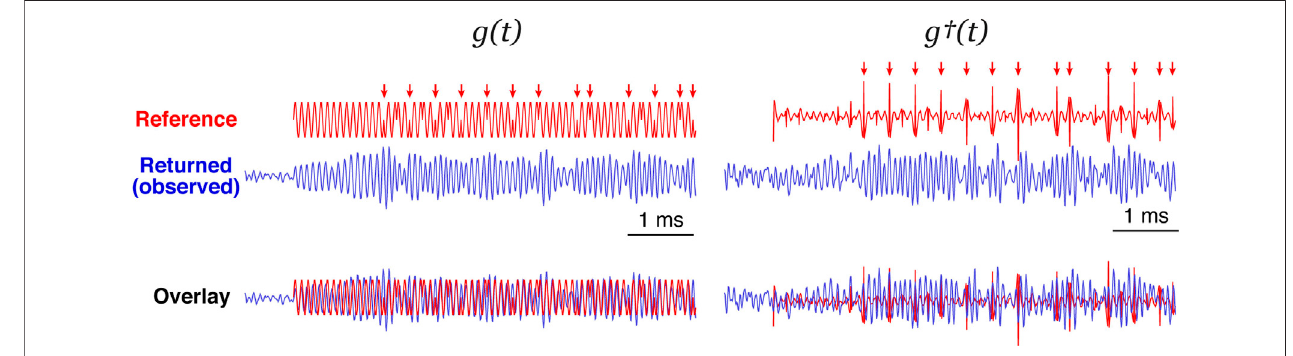
FIGURE 12 | Comparison of the original signal g(t) (left) and the transformed one g † (t) obtained by equalizing amplitudes of all period components (right). The referencesignalandanexampleofactualreturnedsignalareshownbyredand blue,respectively(thebeginning ∼ 6 ms-longpartisshown).Phaseshifts inthereference signal are indicated by red arrows. The reference signal is overlaid on the returned signal (bottom) according to the peak detection